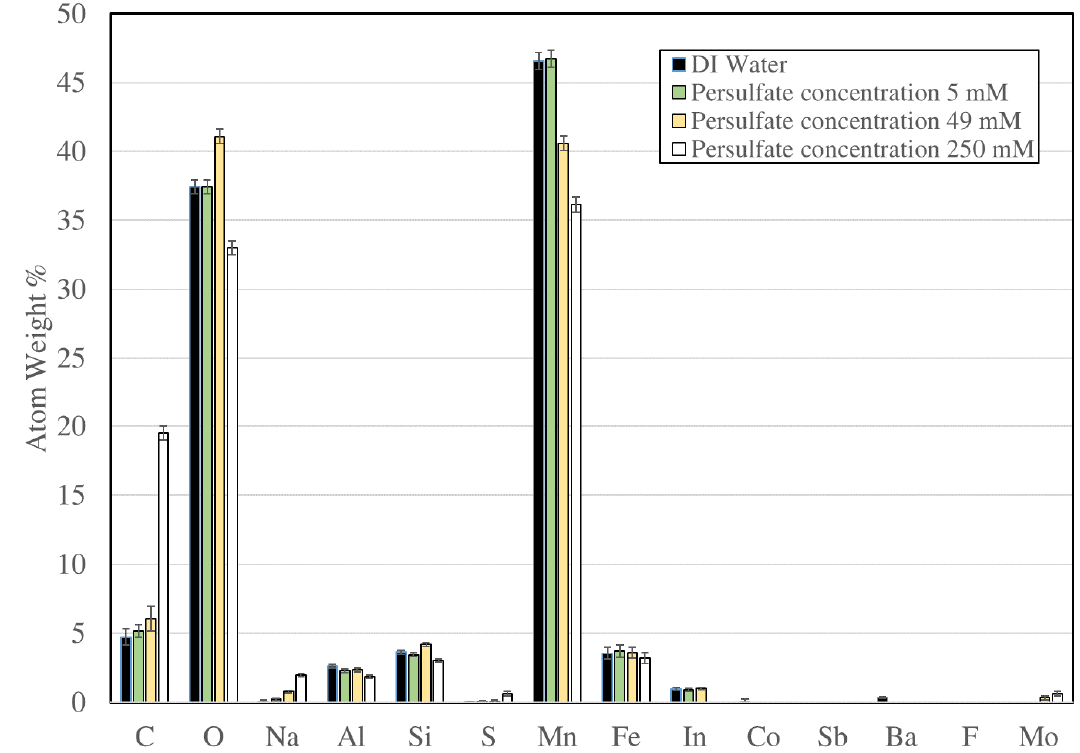
Figure 7. Energy-Dispersive Spectroscopy (EDS) atom weight percentage comparison of MnO 2 reacting with DI water and various concentrations of PS.